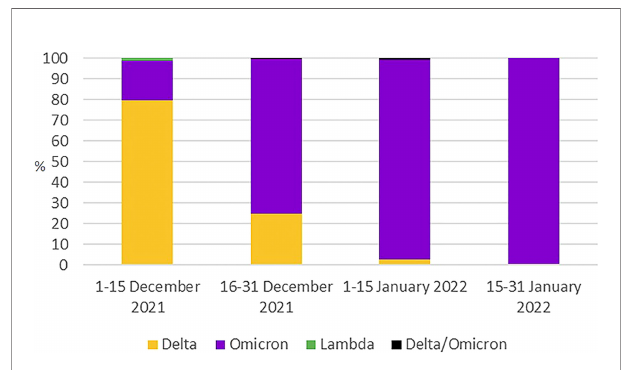
Sample no. 1 contained a suf fi cient viral load and RNA